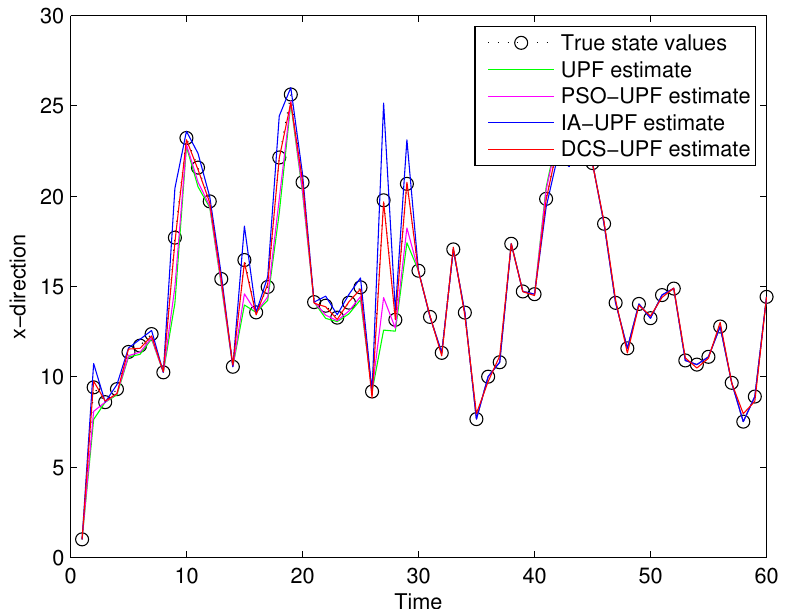
Figure 13. The target trajectory of UPF, PSO-UPF, IA-UPF, DSC-UPF in X-direction.